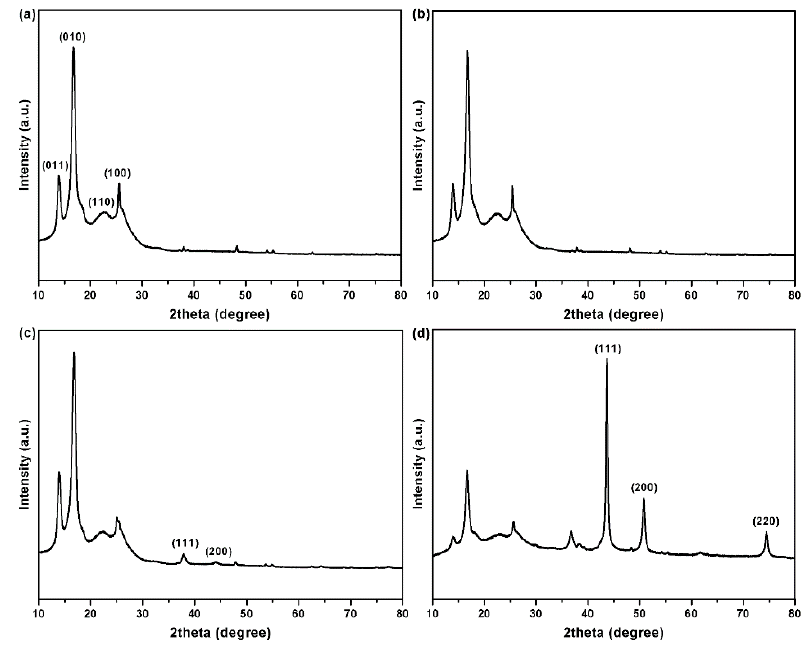
Figure 8. X-ray diffraction (XRD) patterns of ( a ) PET fabrics; ( b ) PDA/PET fabrics; ( c ) Ag/PDA/PET fabrics; and ( d ) Au/Ag/PDA/PET fabrics. fabrics; and ( d ) Au / Ag / PDA / PET